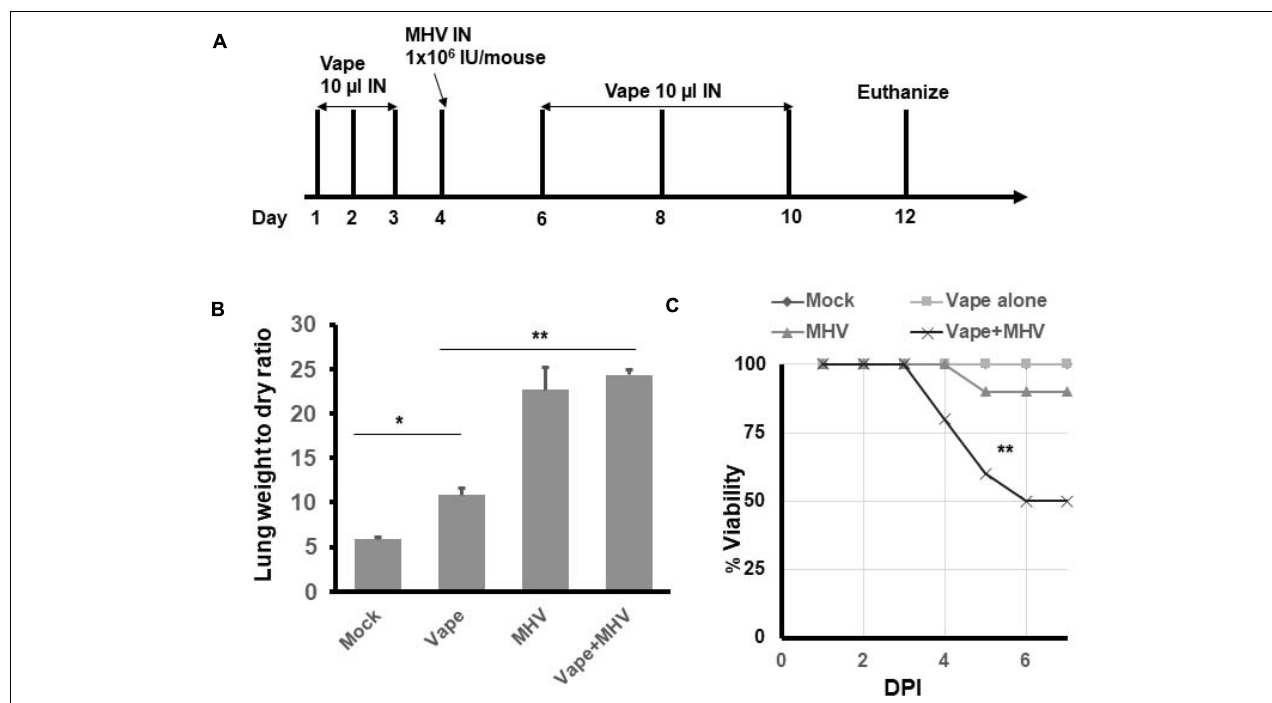
FIGURE 2 | Vaping contributes to increased pulmonary pathology in mice infected with MHV-A59. (A) Study design. (B) Lung wet/dry ratios of mice receiving either PBS (mock), vaped e-liquid, infection with MHV or vaped and infected with MHV (compared with mock). All lungs were harvested on day 12. n = 4 mice (two males and two females) per treatment group. (C) Viability study of vaped mice or mice infected with either MHV or vaped + infected with MHV (compared with mock). n = 4 mice (two males and two females) per group. The mock and vape-alone groups overlay each other so that the mock is not visible. ANOVA was performed to compare among different groups and compared with the mock control using Dunnett’s post hoc test. Symbols and bars represent the mean ± SEM compared with the mock control (* P < 0.05, ** P < 0.01). N.S., not